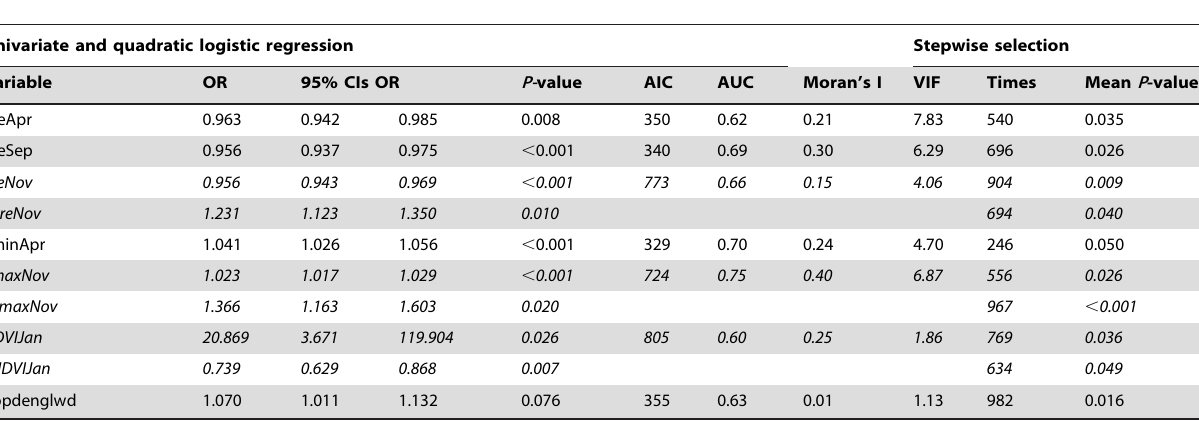
Table 2. Environmental variables kept after the process of stepwise selection using 1000 bootstrapping training datasets. Italics indicate quadratic effects.